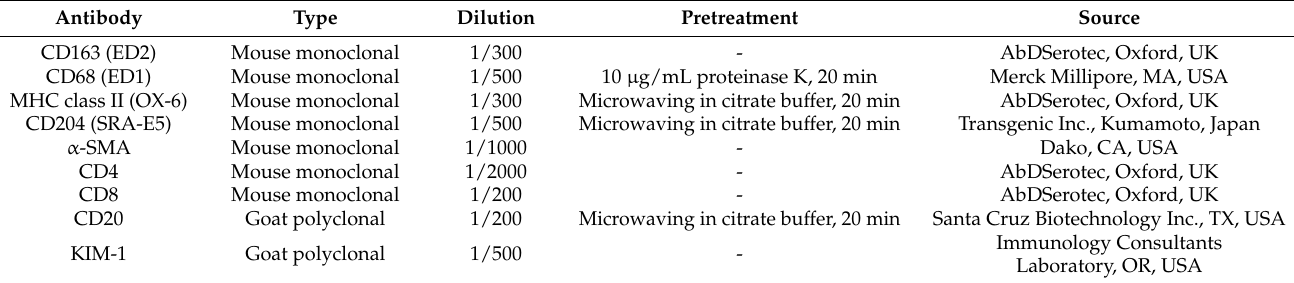
Table 1. Primary antibodies used for immunohistochemistry and